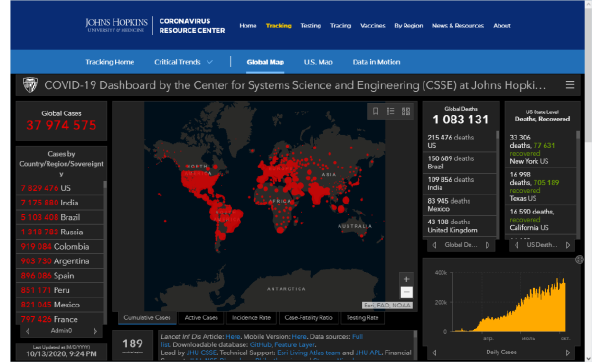
Figure 3. Web interface of the COVID-19 dashboard from the